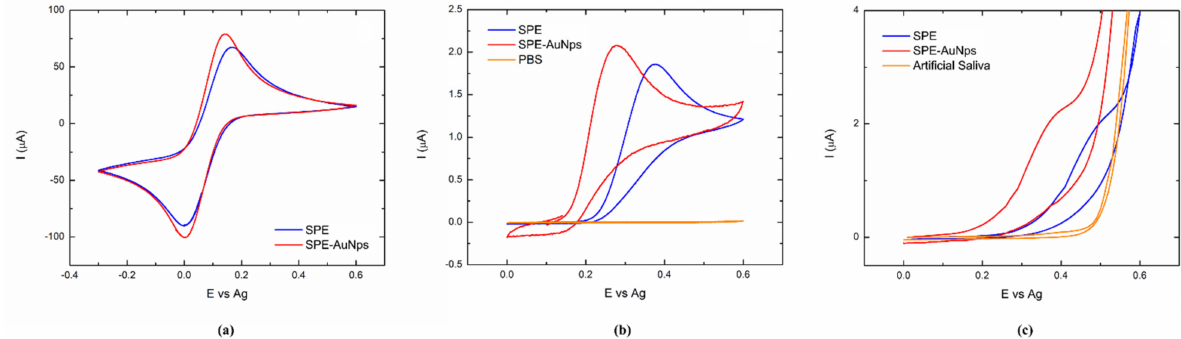
Figure 4. ( a ) Cyclic voltammetry (CV) of 1 mM of K 4 [Fe(CN) 6 ] in bare SPE and SPE-AuNps, ( b ) detection of both electrodes after UA addition in PBS, ( c ) detection of both electrodes after UA addition in artificial saliva. Scan rate in all cases was 50 mV · s − 1